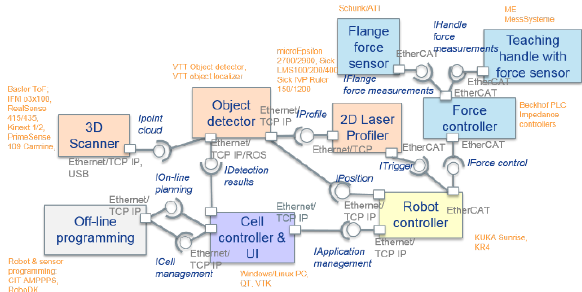
Figure 5: A flexible system architecture for integrating sensor data and robot